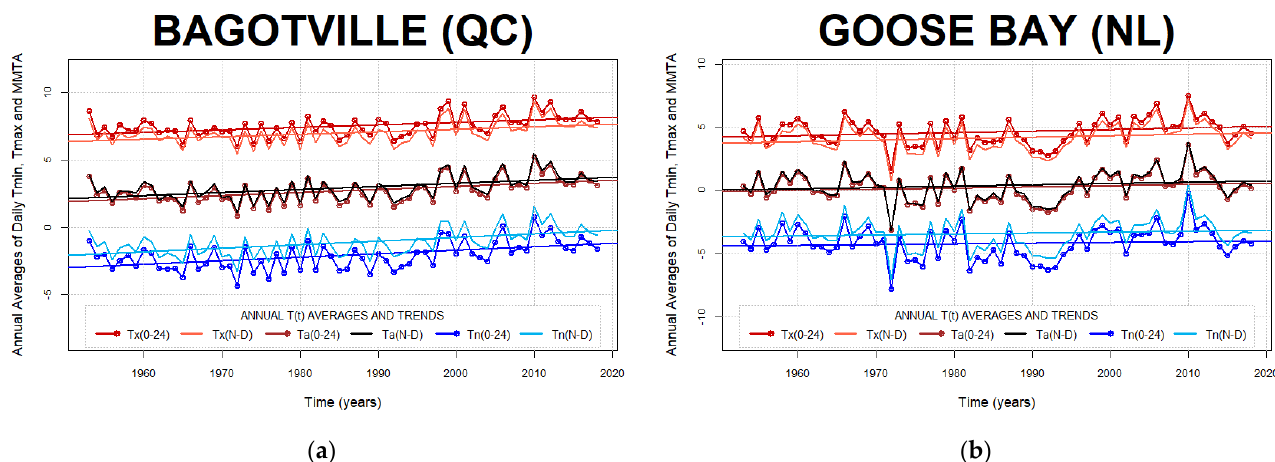
Figure A10. Northeastern Forest climate region. Effect of the observing window on long-term air temperature averaging at Bagotville ( a ) and Goose ( b ) stations. Annually averaged diurnal air temperature minima, maxima, and Min-Max averages obtained with COW 0–24 and COW N–D air temperature approximating methods.